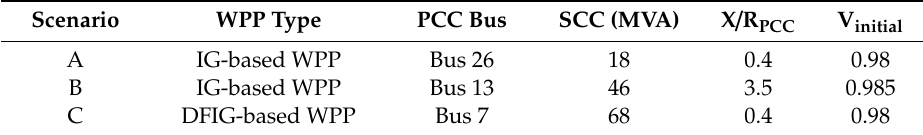
Table 13. WPP type, PCC site and parameters in scenarios considered for the 30-bus